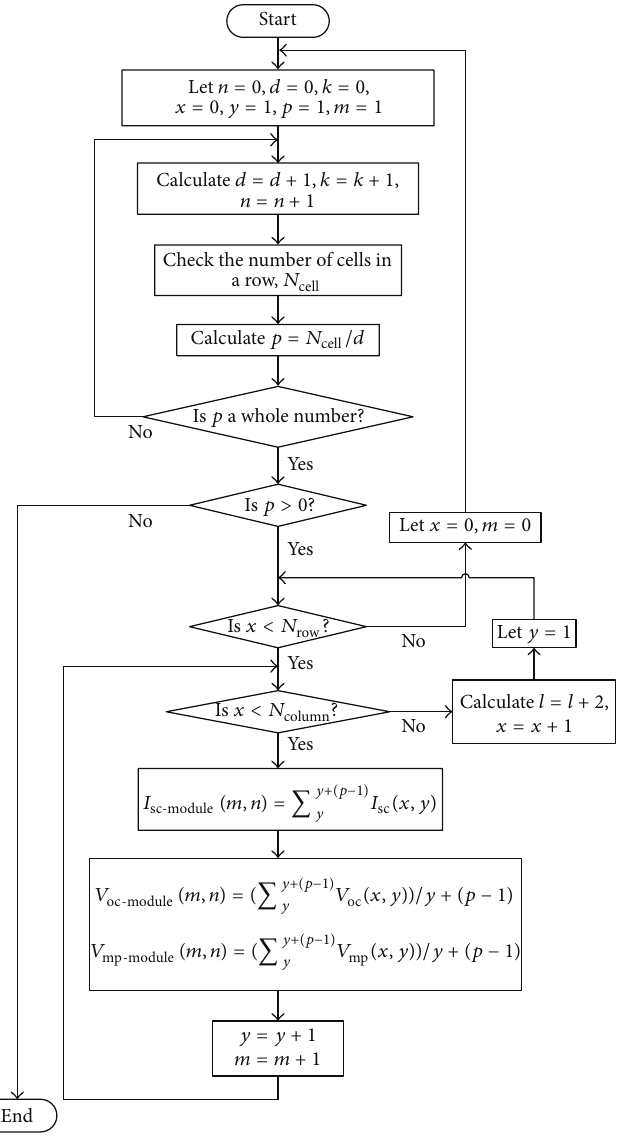
Figure 8: Flowchart of a systematic way of 𝐼